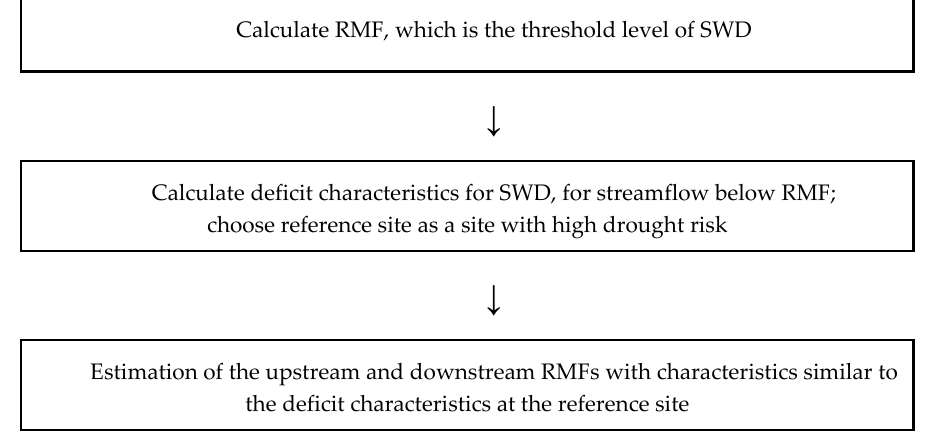
Figure 1. Flow chart of the proposed methodology.